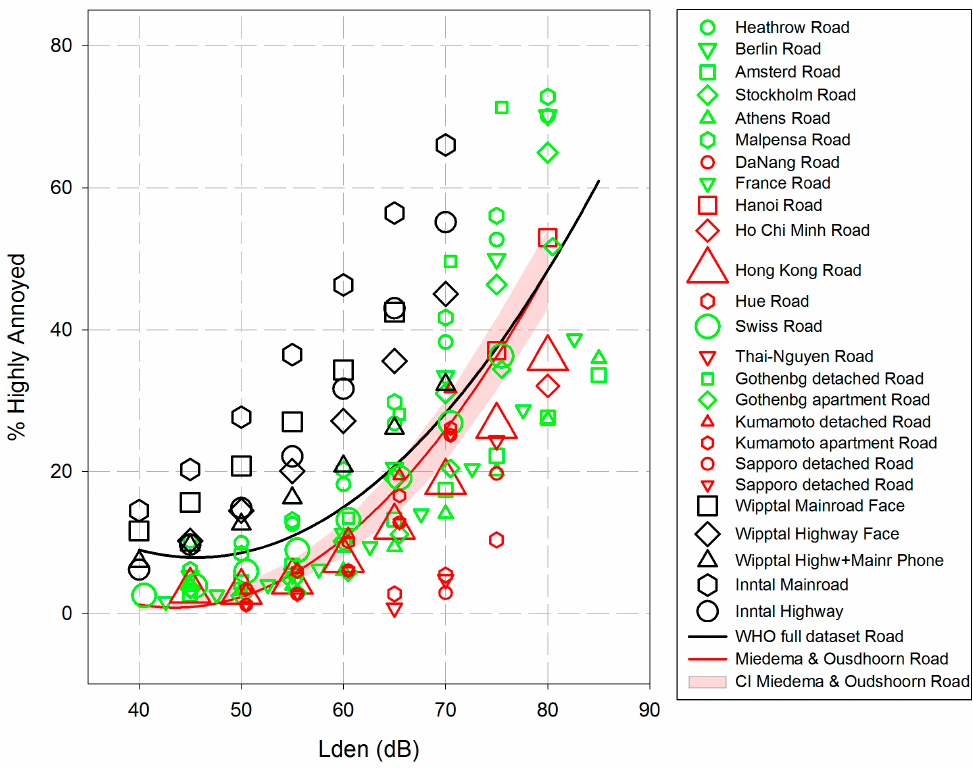
Figure 6. Scatterplot and quadratic regression of the relation between L den and the calculated %HA for 25 road traffic noise studies (black line), together with the exposure ‐ response function by Miedema and Oudshoorn [4] (red line). Notes 6: (1) Black symbols refer to valley studies, red symbols refer to Asian studies, and green symbols refer to European no ‐ valley studies. (2) The size of the data points corresponds to the number of participants in the respective study (size = SQRT(N)/10). (3) If two results from different studies fall on the same data point, the last point plotted may mask the former one. (4) The black curve is derived from aggregated secondary data, while the red one is derived from individual data.